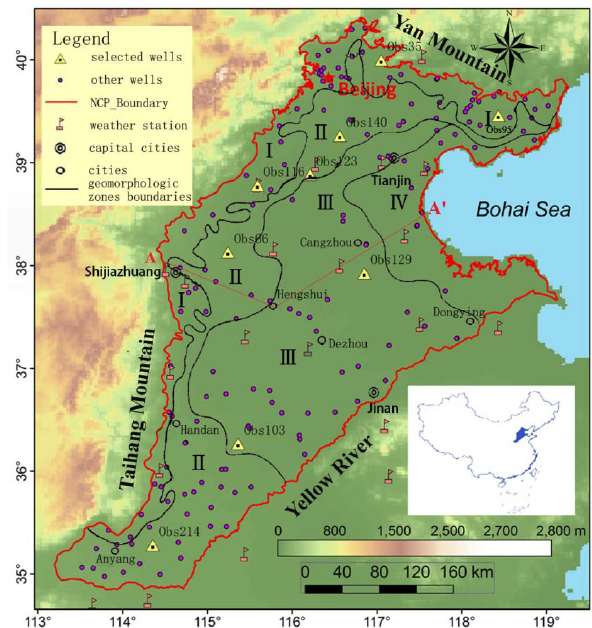
Fig. 1. Location and topography of the North China Plain, spanning Fig.1. Location and topography of the North China Plain, spanning from 32°N to 40°N and 971 from 32 ◦ N to 40 ◦ N and from 114 ◦ E to 121 ◦ E (Cao et al., 2013). (1) Locations of meteorological stations and observation wells: the from 114°E to 121°E (Cao et al., 2013). (1) Locations of meteorological stations and 972 wells marked with rectangles are the selected wells used to show the observation wells: the wells marked with rectangles are the selected wells used to show the 973 calibration and validation results of groundwater heads; (2) bound- aries of geomorphologic zones: (I) piedmont plain, (II) alluvial fan, calibration and validation results of groundwater heads; (2) Boundaries of geomorphologic 974 (III) alluvial plain, and (IV) coastal plain (Wu et al., 1996; Cao et al., 2013); (3) locations of capital cities (Beijing, Tianjin, Shijiazhuang zones: (I) piedmont plain, (II) alluvial fan, (III) alluvial plain, and ( Ⅳ ) coastal plain (Wu et 975 and Jinan) and some other cities that are included and considered in the NCP al., 1996; Cao et al., 2013); (3) Locations of capital cities (Beijing, Tianjin, Shijiazhuang 976 and Jinan) and some other cities that are included and considered in the NCP model. 977